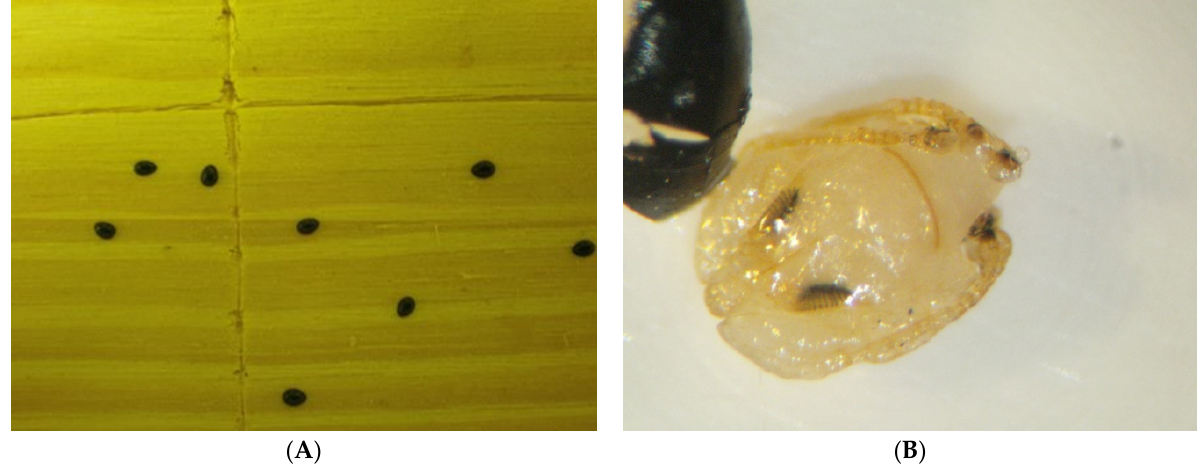
Figure 9. Bat fly pupae deposited on wooden plank ( A ). Emerging bat fly ( B ). Table 3. Number of F1 generation pupal and adult bat flies counted and collected for testing in cages housing flies fed on subcutaneously (SC) inoculated bats (C1–C5) with Marburg virus (MARV) and in cages (C6–C8) housing flies administered MARV by intra ‐ coelomic inoculation (IC).